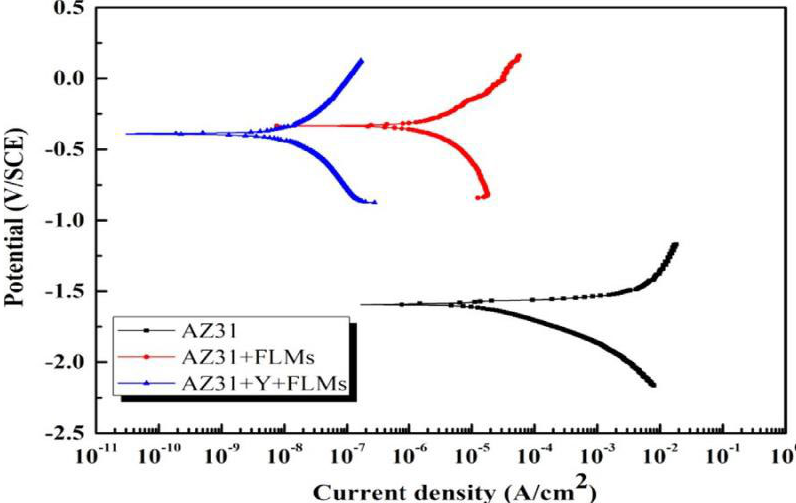
Figure 49. Potentiodynamic polarization curves of bare AZ31, AZ31 + FLMs and AZ31 + Y + FLMs measured after immersion for 1 h in 3.5 wt.% NaCl solution. Reprinted with permission from [86]. Copyright 2021